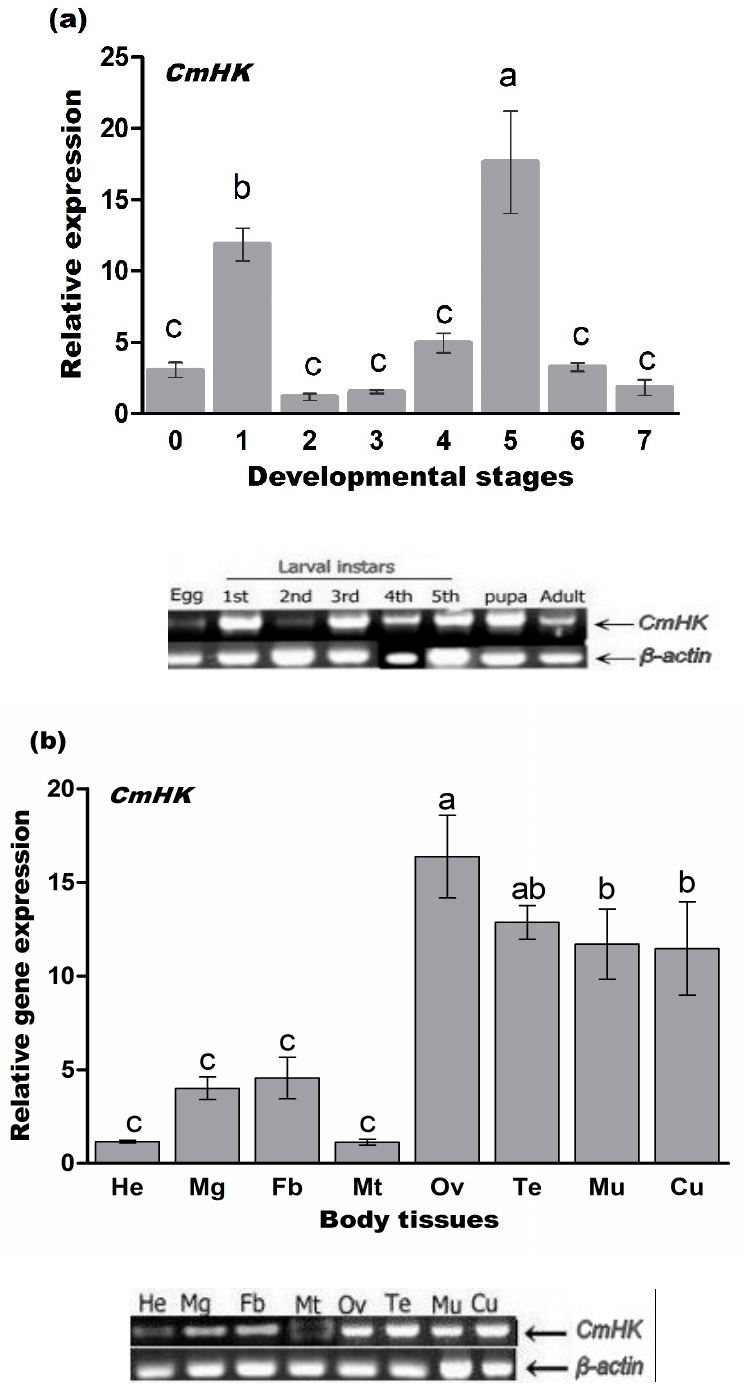
Figure 2. Expression pattern of CmHK in different tissues and at different developmental stages of C. medinalis adults. ( a ) Expression pattern of CmHK in eggs (0), the first to fifth instar larvae (1–5), pupae (6), and adults (7) of C . medinalis . ( b ) Expression pattern of CmHK in the head (He), midgut (Mg), fat body (Fb), malpighian tubules (Mt), testes (Te), muscle (Mu), cuticle (Cu), and ovary (Ov). Relative mRNA levels of CmHK were analyzed using RT-qPCR. β -actin is used as an internal control. Each bar indicates the mean ± SD , and different letters above each bar represent a significant difference ( P < 0.05 , LSD and ANOVA) from three independent experiments.